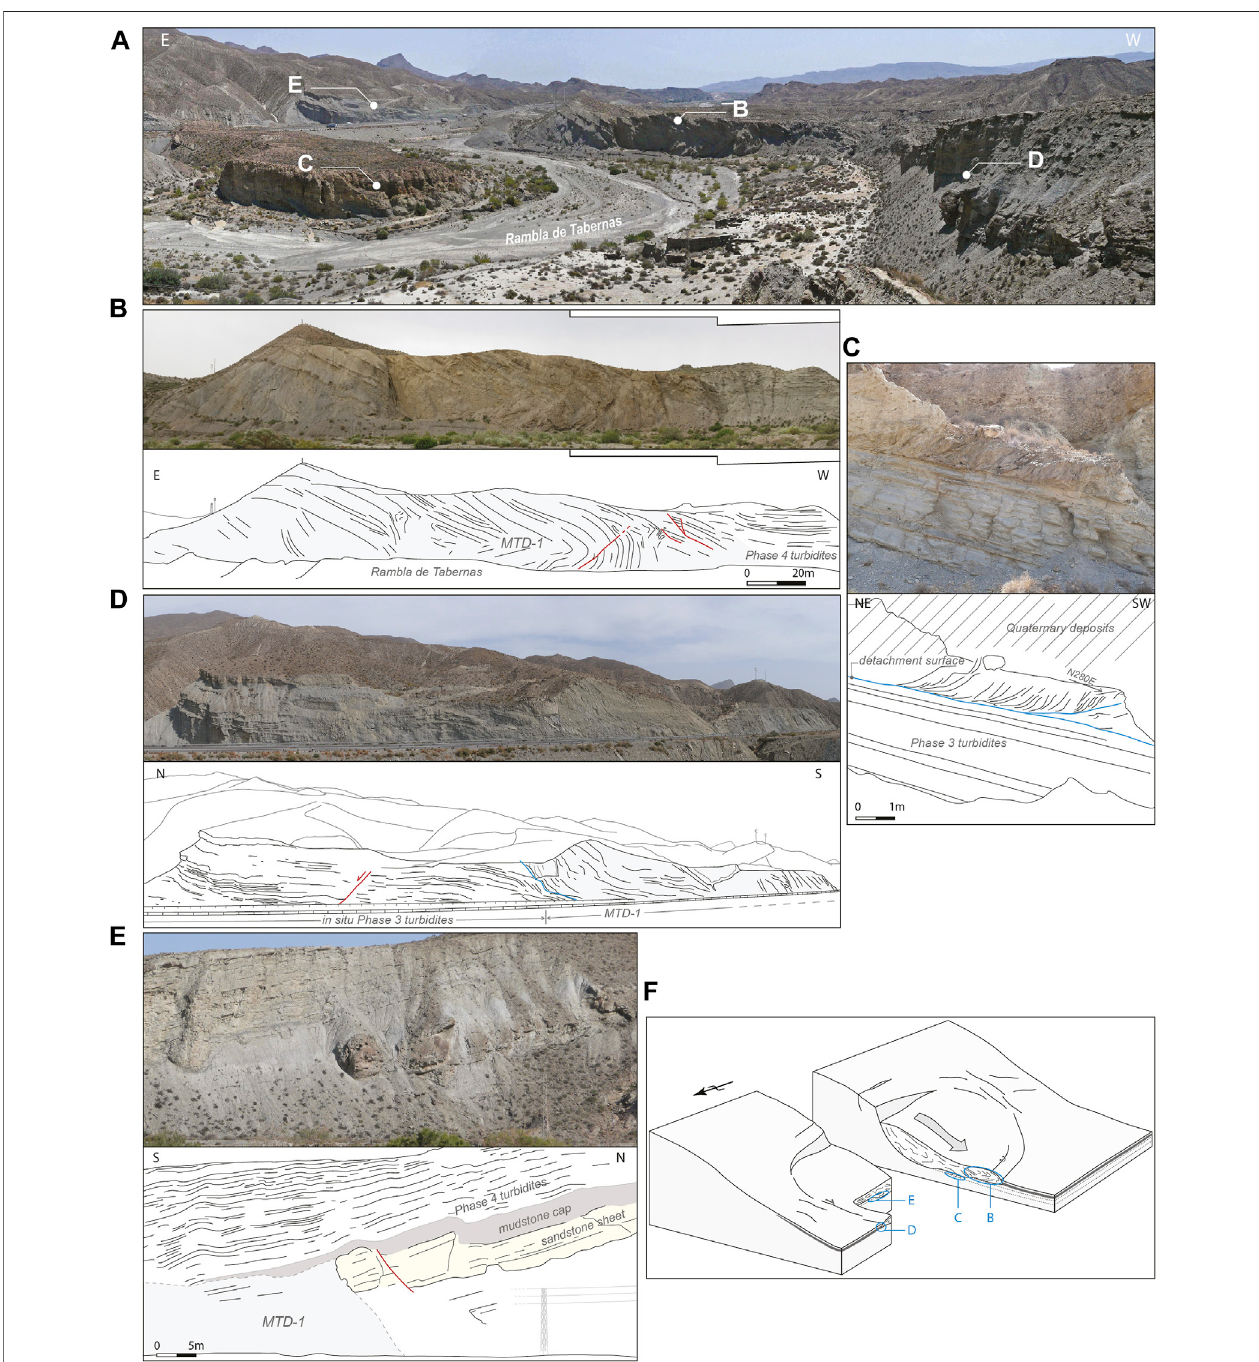
FIGURE 11 | Character of MTD-1 (see Figure 4 for location) (A) General panorama of MTD-1 outcrops looking south down Rambla de Tabernas (B) Photograph and line drawing of a large recumbent fold at the toe of MTD-1 (highlighted in grey). In-situ Phase 4 turbidites draping the toe of MTD-1 occur on the western side of the outcrop.Faultsdevelopingwithinthefoldarehighlightedinred (C) Photographandlinedrawingofthebasaldetachmentzonecharacterisedbythepresenceofduplexes formed by deformation of Phase 3 turbidites above the detachment surface (highlighted in blue). A westwards transport direction is deduced from the duplex orientation (D) Photographand linedrawing ofthelateraldetachment (blue)ofMTD-1(in grey)cuttingthroughPhase3turbidites hereobservedalongtheN340road (E) Photograph and line drawing of a Phase 4 megabed truncated by MTD-1 (highlighted in grey). Note the geometric relationship between the MTD and the megabed with the sandstone division of the megabed (highlighted in yellow) cut vertically by the lateral edge of the MTD but with the mudstone cap (highlighted in dark grey) overstepping the MTD (F) Schematic block diagram illustrating the 3D structure of MTD-1 (modi fi ed from Bradley and Hanson (1998)). The letters refer to the different components of the MTD illustrated in the preceding parts of the fi gure.